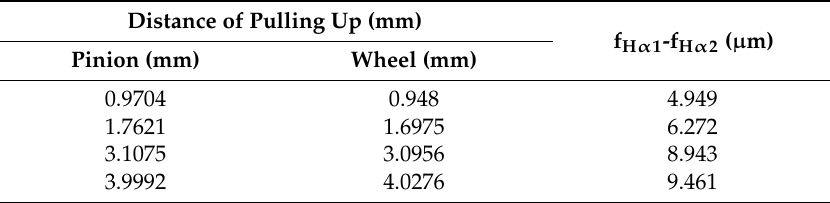
Table 4. Di ff erence of profile slope deviation between pinion and